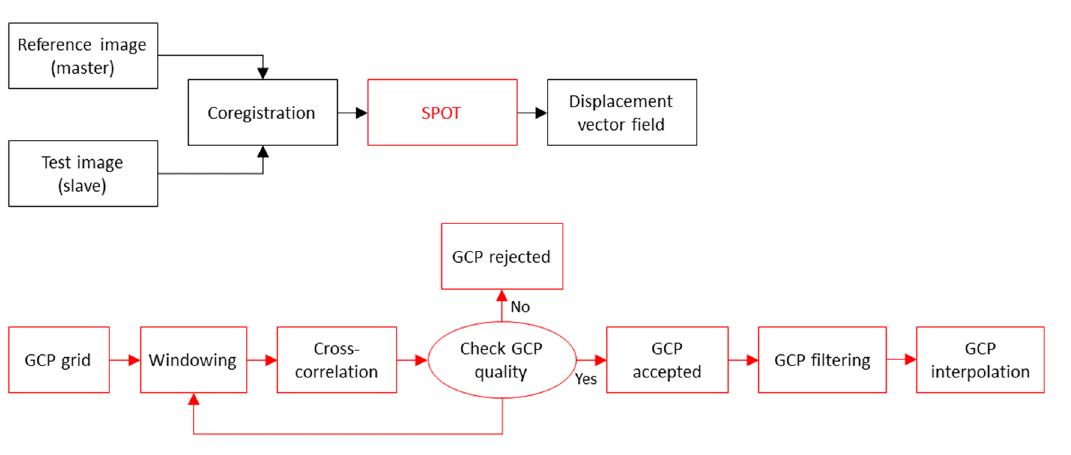
Figure 2. Flow diagram of the implemented methodology. The upper part of the picture shows the general processing chain, while in the lower part the flux represents an exploded view of the Sub-Pixel Offset Tracking (SPOT) processing block.